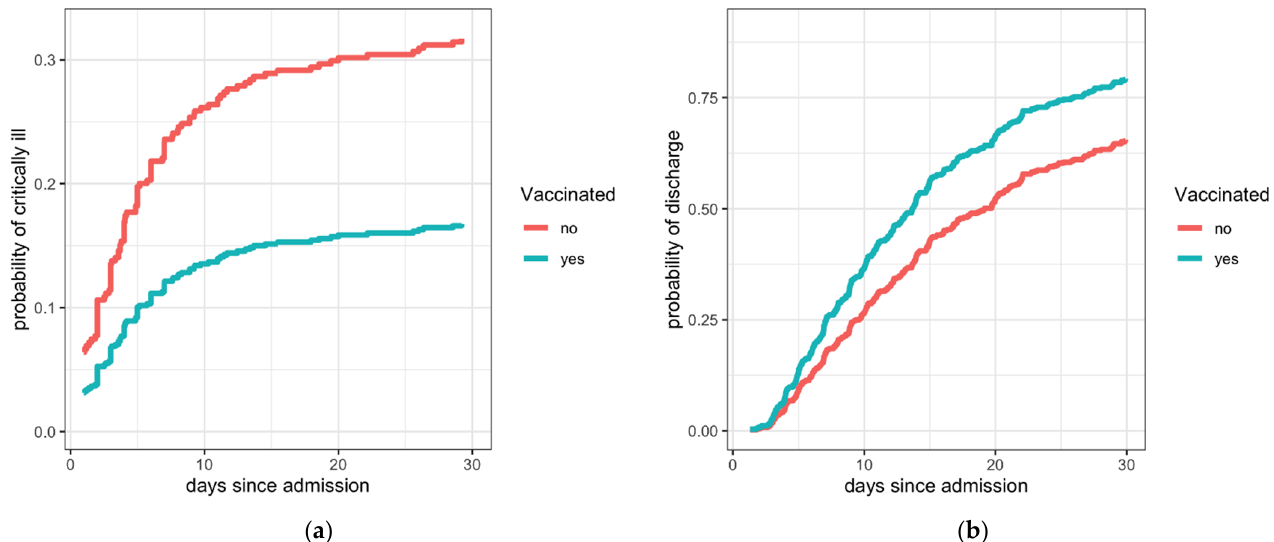
Figure 2. Modelled probability of progression to critically severe disease ( a ) and probability of discharge from the hospital ( b ) by vaccination status (vaccinated vs. unvaccinated) as assessed from Fine–Gray time-to-event models for two male patients with COVID-19 who were 75 years old, with Charlson comorbidity index 3, and without immunocompromising conditions. Table 3. Subdistribution hazard ratios for discharge from the